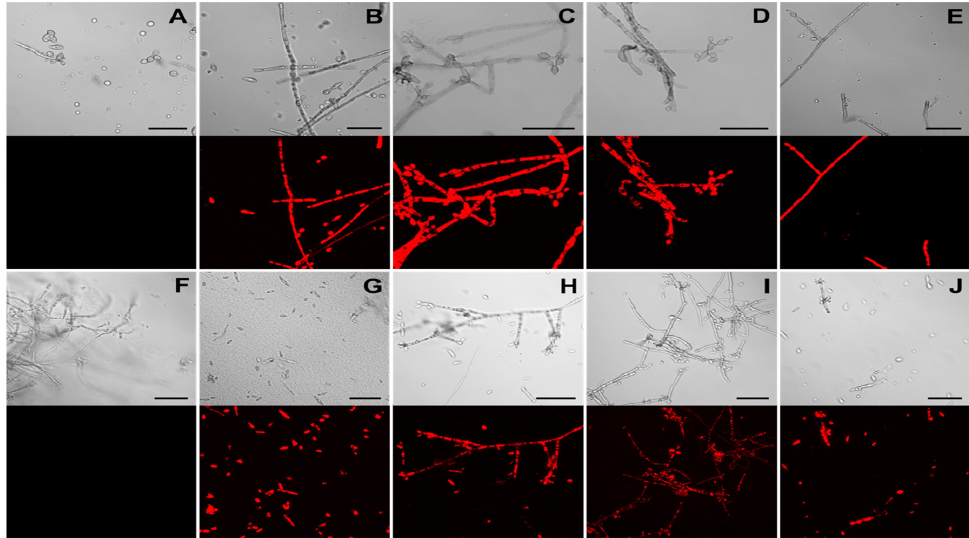
Figure 4. Detection of DsRed fluorescence in Fonsecaea erecta ( A – E ) and Fonsecaea monophora ( F – J ) by confocal microscopy. Images of wild-type ( A , F ) and transformed strains F. erecta 1-pCAMDsRed ( B ), 2-pCAMDsRed ( C ), 3-pCAMDsRed ( D ) and 4-pCAMDsRed ( E ); F. monophora 1-pCAMDsRed ( G ), 2-pCAMDsRed ( H ), 3-pCAMDsRed ( I ) and 4-pCAMDsRed ( J ) are shown. The upper panels depict DIC (Differential Interference Contrast) images and the red emitted fluorescence panels are on the bottom. The transformants of F. erecta (4-pCAMDsRed) and F. monophora (4-pCAMDsRed) characterized by red fluorescent were inoculated into the model plant B. gasipaes, with the wild-type strains as control. Fonsecaea erecta and F. monophora expressed red fluorescent proteins while colonizing the intercellular spaces (Figure 5).